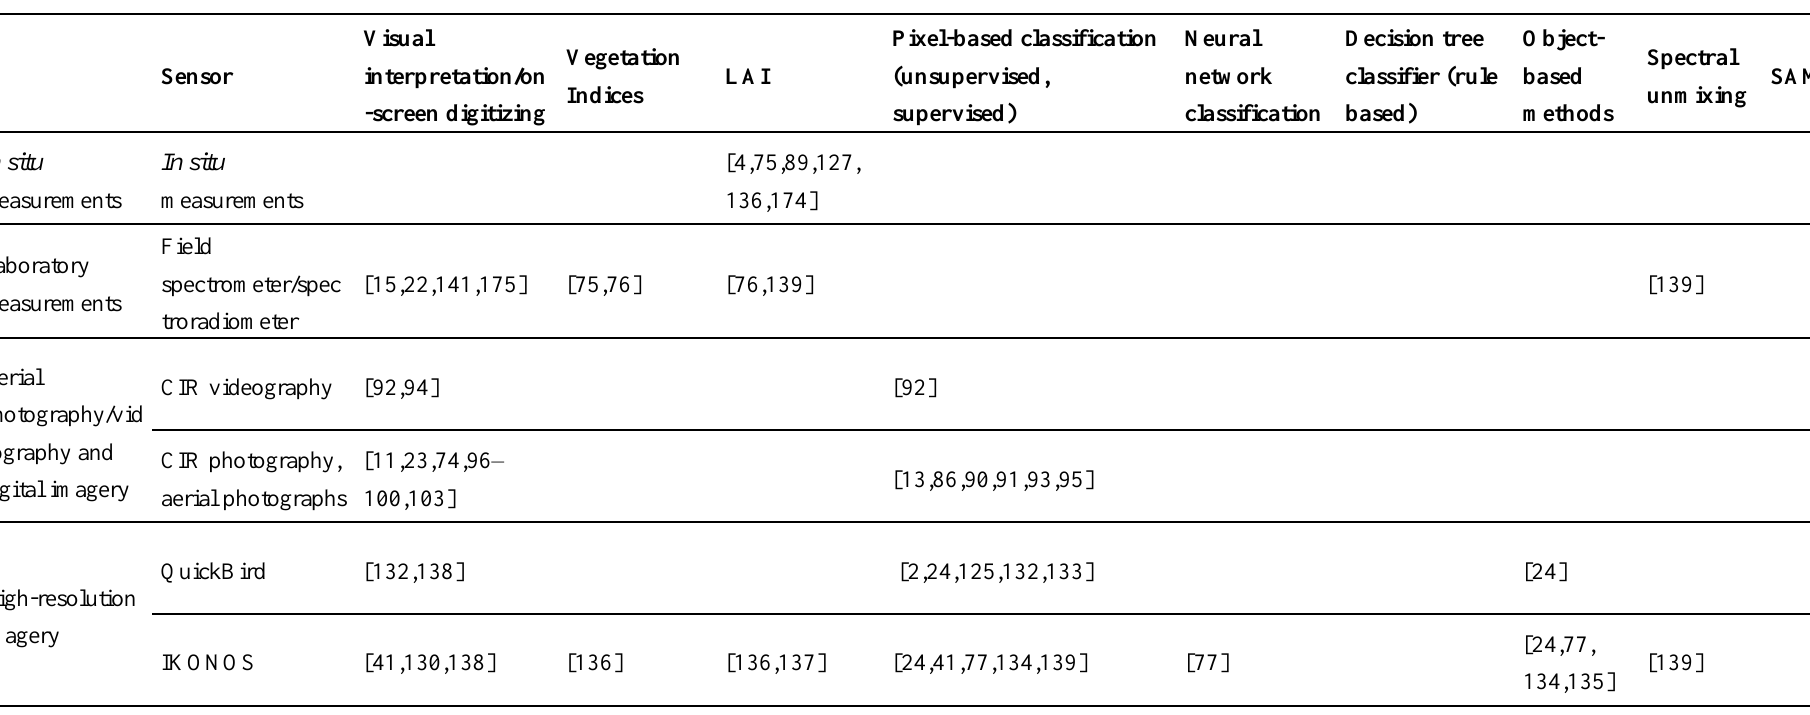
Table 2. Overview of sensors and methods used for the assessment of mangrove ecosystems during the past 20 years (see ―References‖ for exact